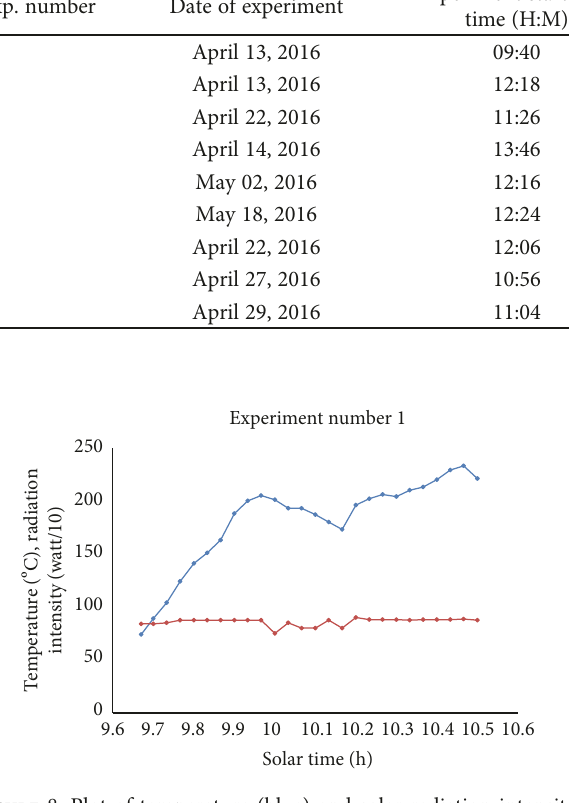
Figure 8: Plot of temperature (blue) and solar radiation intensity (red) versus time for the fi rst unloaded experiment. Radiation intensity is divided by 10 to fi t the scale.